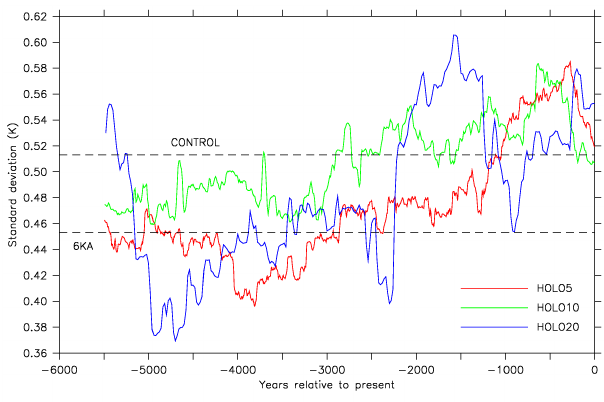
Fig. 12. The evolution of the standard deviation of the monthly sea surface temperature anomaly in the Ni˜no 3.4 region (170–120 ◦ W, 5 ◦ S–5 ◦ N) during experiments HOLO5 (red), HOLO10 (green) and HOLO20 (blue). A moving window with a width of 1000 calendar years is used to calculate the standard deviation. Horizontal dashed lines show the amplitude of ENSO variability in experiments CON- TROL and